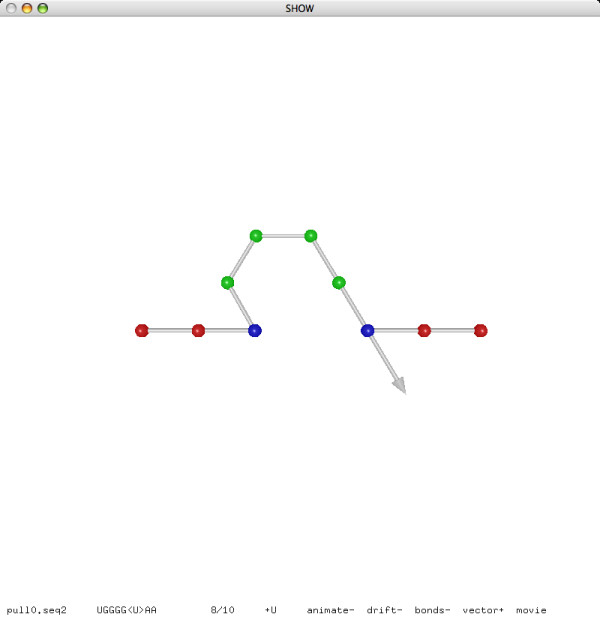
A pull move (before).